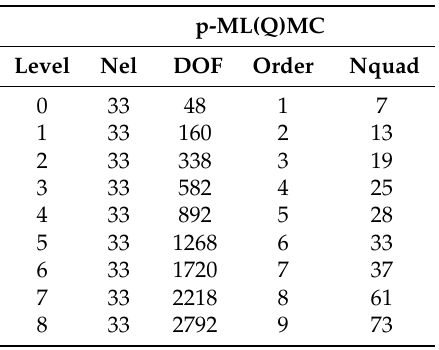
Table 4. Number of elements, degrees of freedom, element order and number of quadrature points for model problem 2 for additional